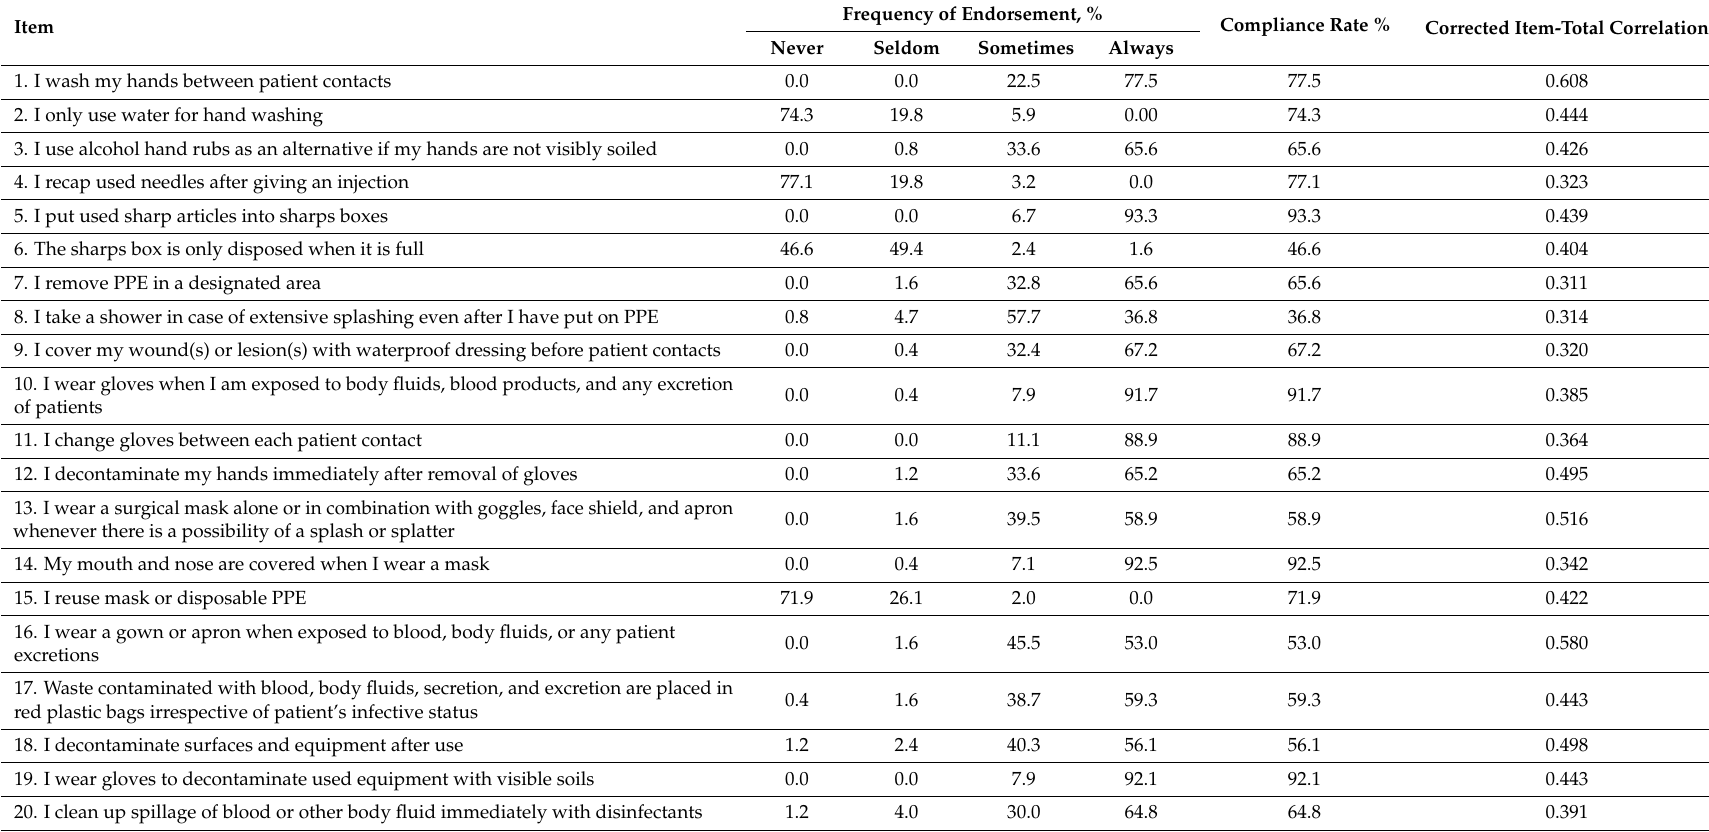
Table 3. Compliance rate and item total correlation coefficients of the